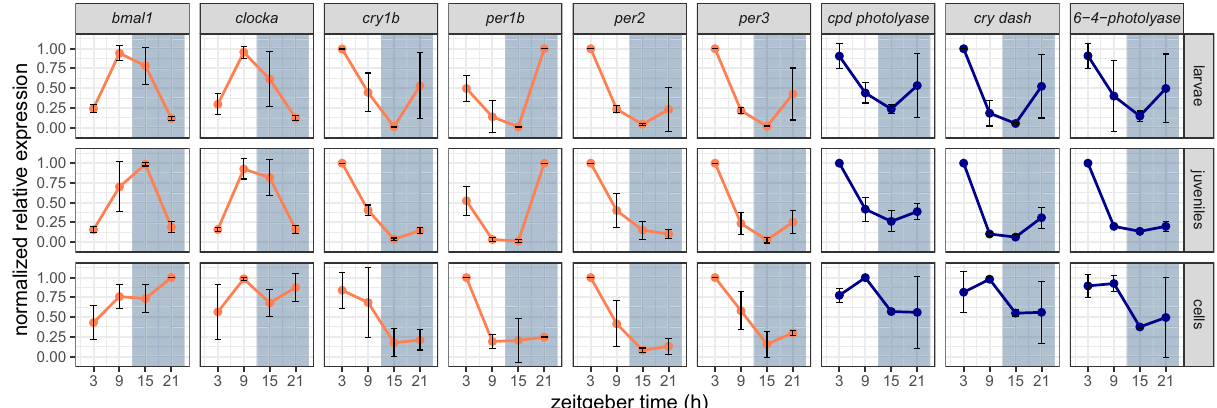
Figure 2. Mean normalized expression of six clock genes (orange traces): bmal1 , clocka , cry1b , per1b , per2 , per3 and three genes of the photoreactivation DNA repair mechanism (blue traces): cpd photolyase , cry dash , 6-4-photolyase of Amphiprion ocellaris cells, larvae and juveniles. Expression was quantified using quantitative real time PCR at zeitgeber time (h) 3, 9, 15 and 21. Lights were switched off at zeitgeber time 12, indicated by bluish-grey background. Per timepoint, three samples for larvae and juveniles and two samples for cells were analysed. The cycling expression pattern of clock genes as well as genes of the photoreactivation repair mechanism was similar between larvae and juveniles. The expression pattern of the period genes and cry1b , as well as the photolyase genes in the EAO cell line resembled those in the larvae and juveniles. However, expression of clocka and bmal1 showed a non-cycling pattern in the EAO cells compared with the high amplitude rhythmic expression observed in the animal